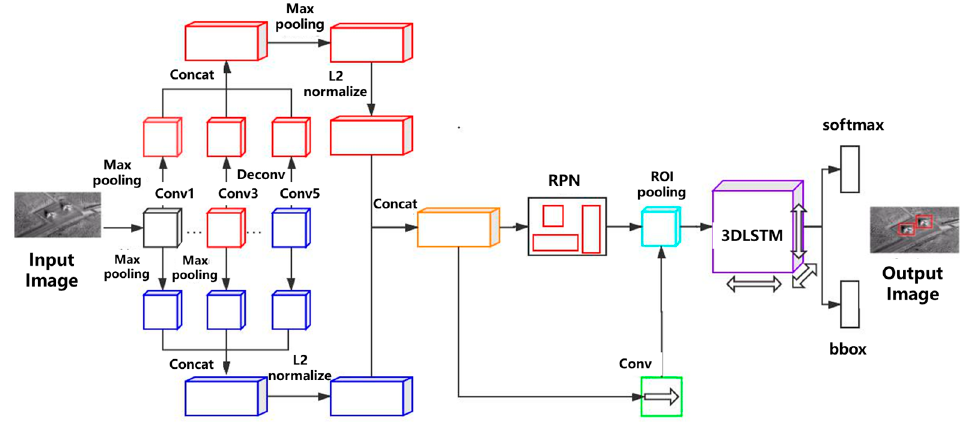
Figure 5. Structure diagram of CMF-3DLSTM model.